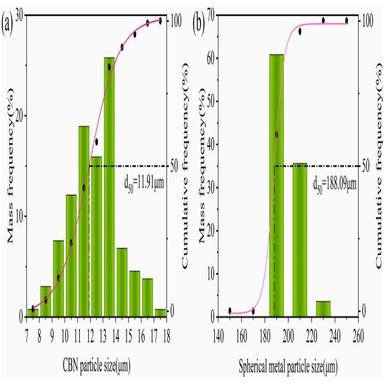
Size distribution diagram: (a)cBN powder; (b) spherical metal powder.